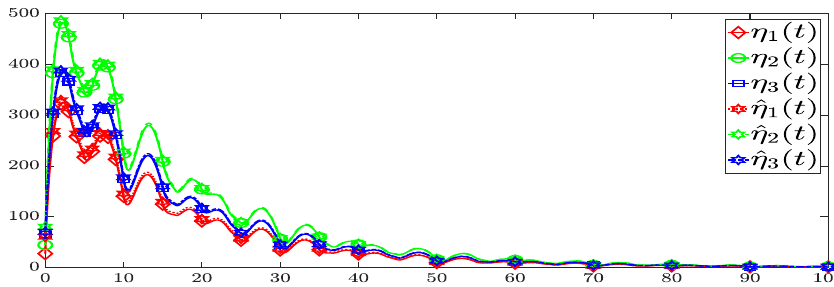
Figure 2. The state trajectories of system (1).